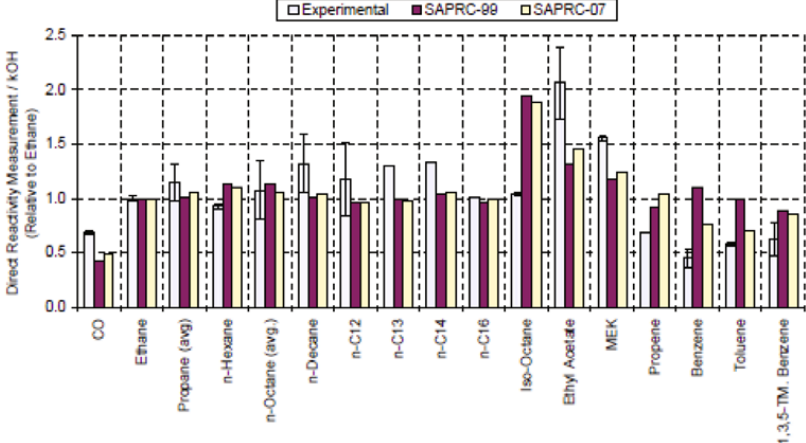
Fig. 10. Model performance of hydrocarbon reactivity in comparison to data obtained from environmental cham- bers